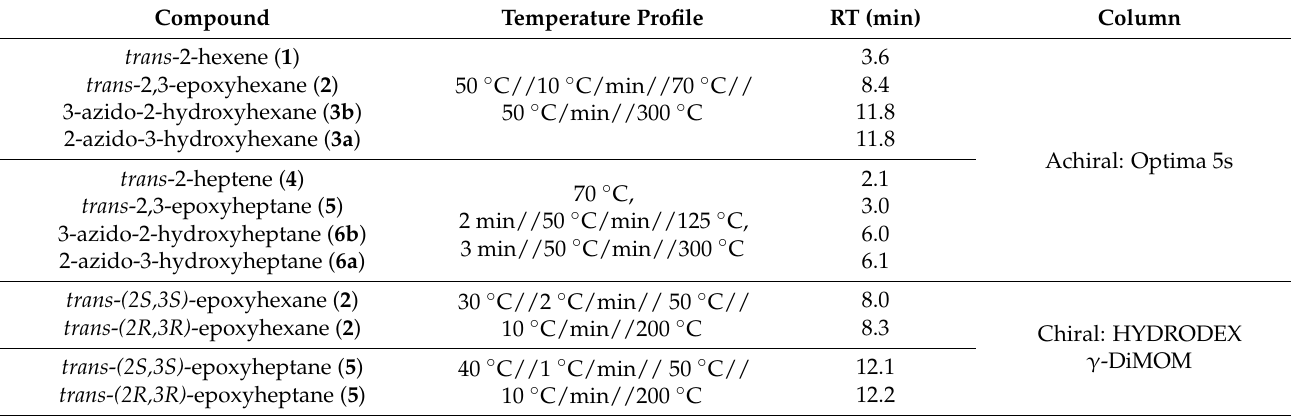
Table 5. Temperature programs and columns used for analysis of the different compounds on achiral or chiral GC as well as resulting retention